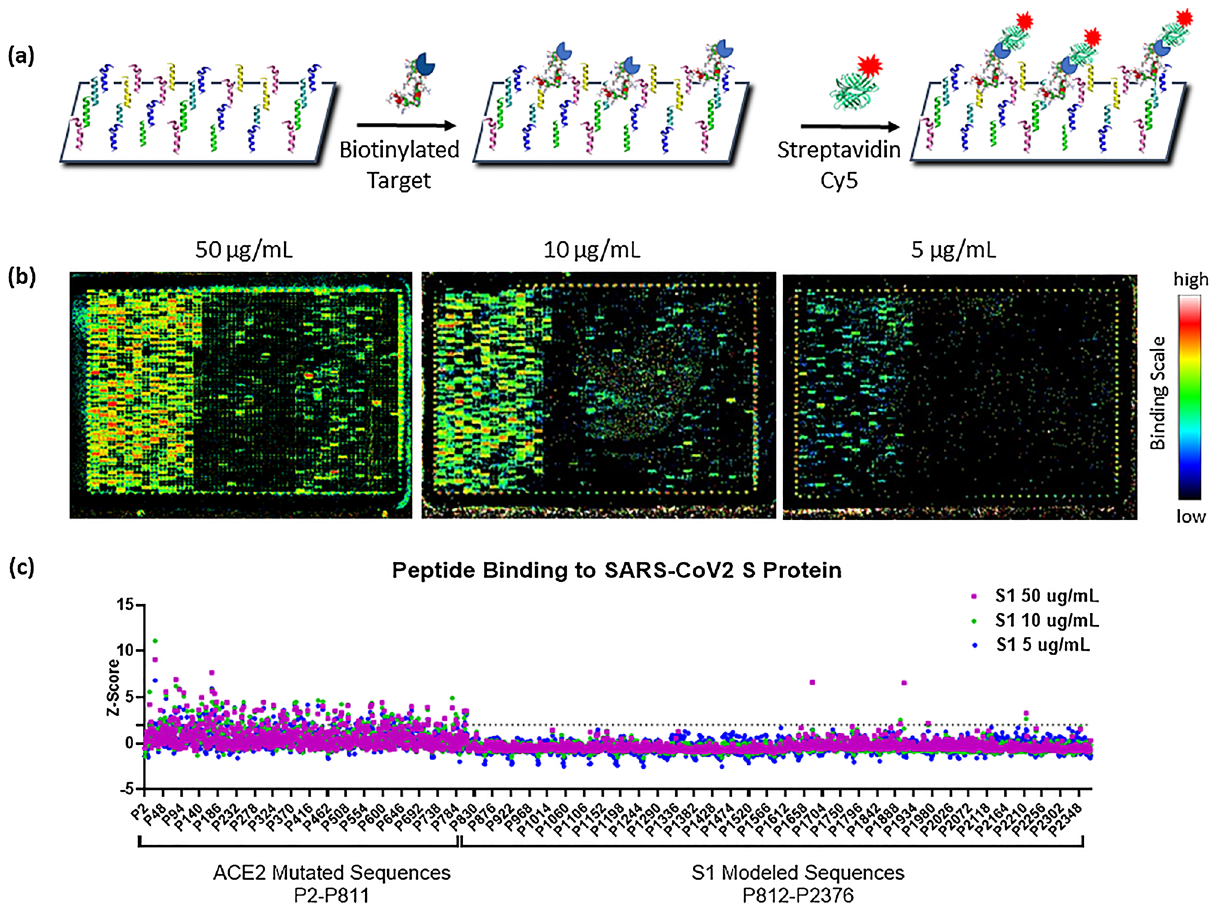
Figure 1. Peptide Microarray to Identify SARS-CoV-2 S Protein Binding Sequences. ( a ) Schematic showing microarray screening procedure for detecting binding of a biotinylated target protein. ( b ) Microarray images of peptide subarray following exposure to 50, 10, or 5 µg/mL of SARS-CoV2 S1 protein. ( c ) Normalized binding signal of peptides after exposure to SARS-CoV2 S1 protein at 50, 10, or 5 µg/mL concentration. Z-score at each S1 concentration is plotted for peptides listed in numerical order along the X-axis. P2-P811 correspond to peptides derived from the ACE2 N-terminal alpha helix (approach 1) while P812-P2376 were derived from a random starting library and screened in silico for docking to S protein (approach 2). Peptides with high Z-scores (> 1.95, indicated by dotted line) represent S1 protein binding